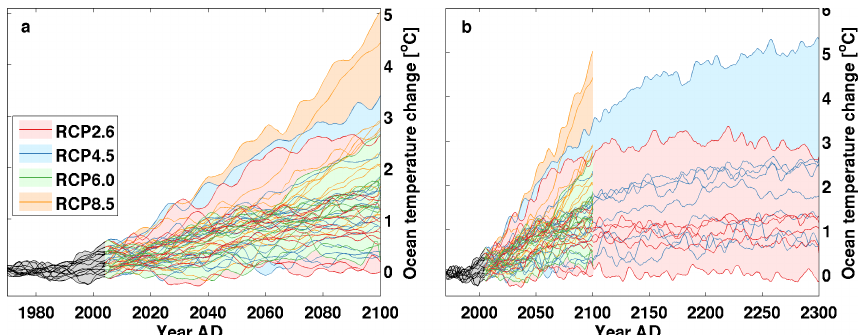
Figure 5. Mean annual ocean temperature anomaly around Greenland with respect to the reference period 1960–1990. Panels cover different time periods up to 2100 (a) and 2300 (b) . Thin lines represent individual projections and the lighter background shading covers the area between the minimum and maximum realisation for each RCP except when they overlap with other scenarios. Temperature anomalies are averaged over the five ocean basins. Prior to 2005, ocean forcing is taken from each individual climate model (grey shading and black